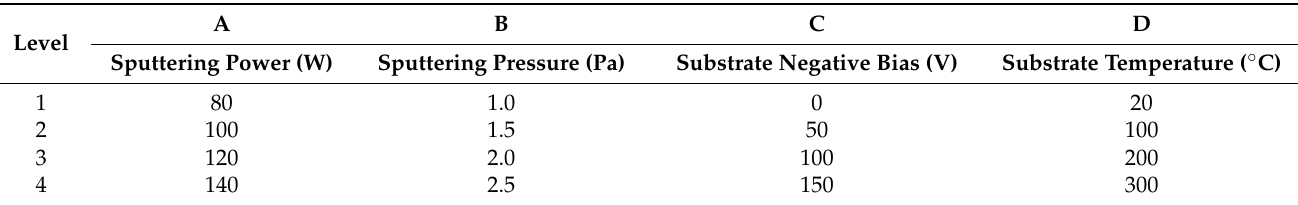
Table 5. Level table of orthogonal test factors of Ni-Cr alloy